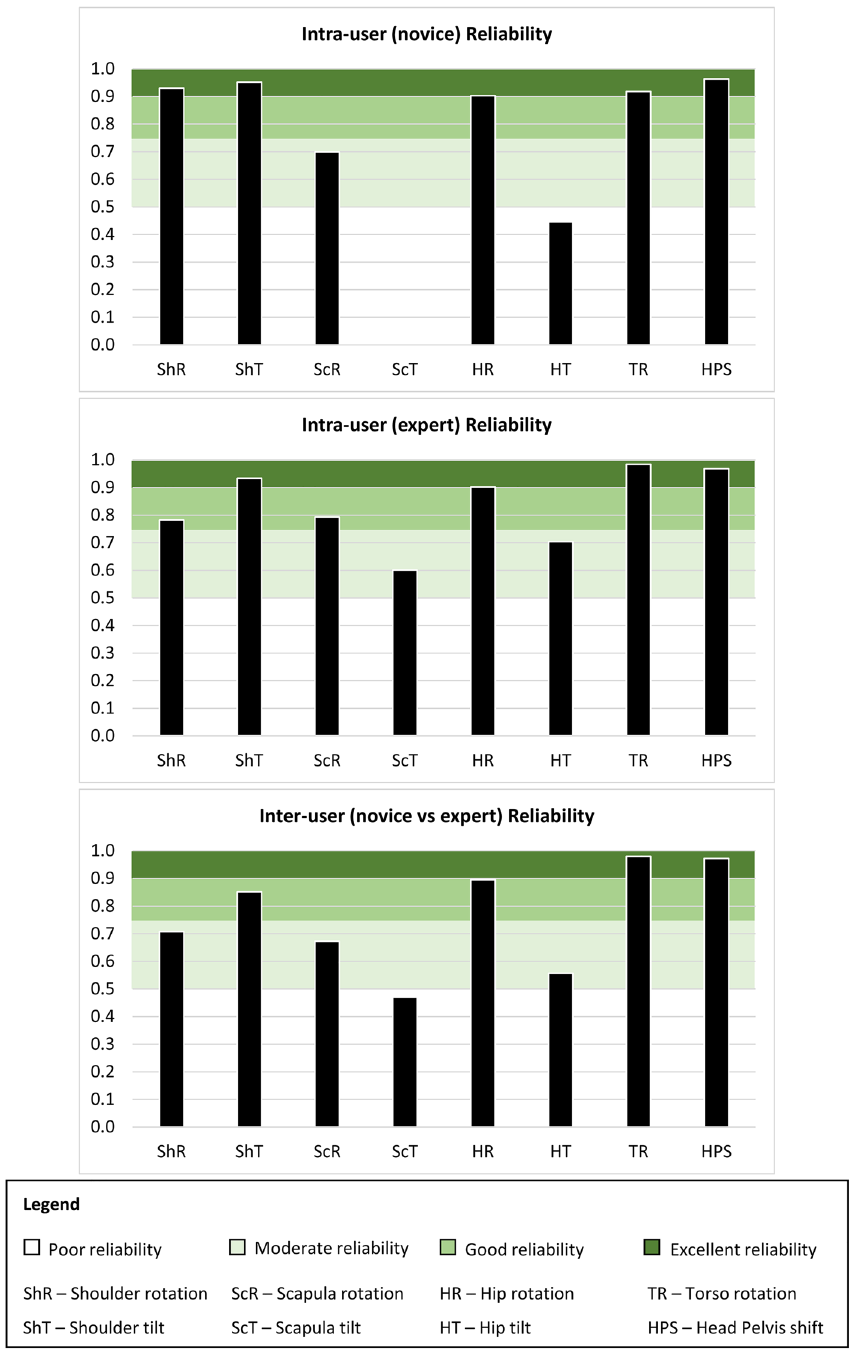
Fig 6. ICC reliability scores for intra-user and inter-user